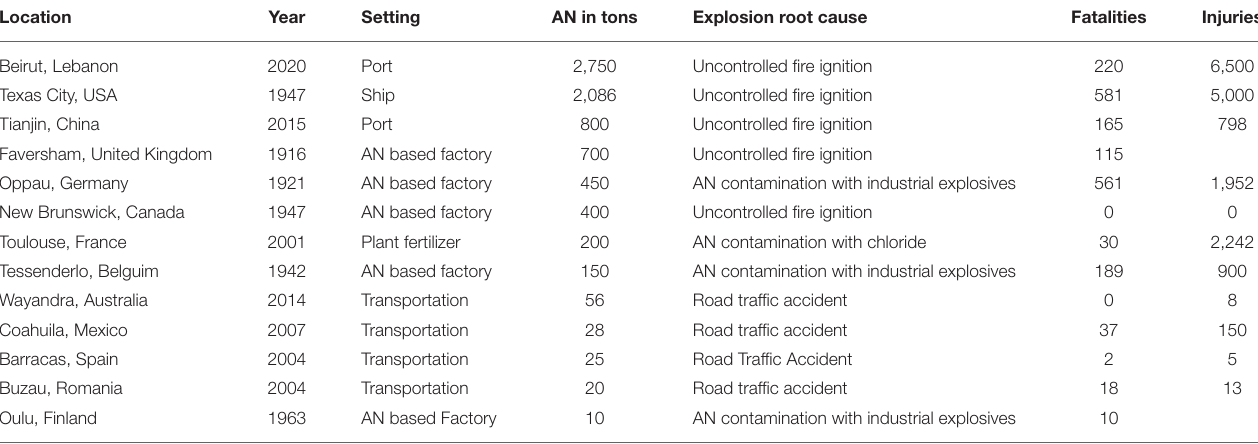
TABLE 1 | Characteristics for the top 6 most devastating ammonium nitrate explosions globally.